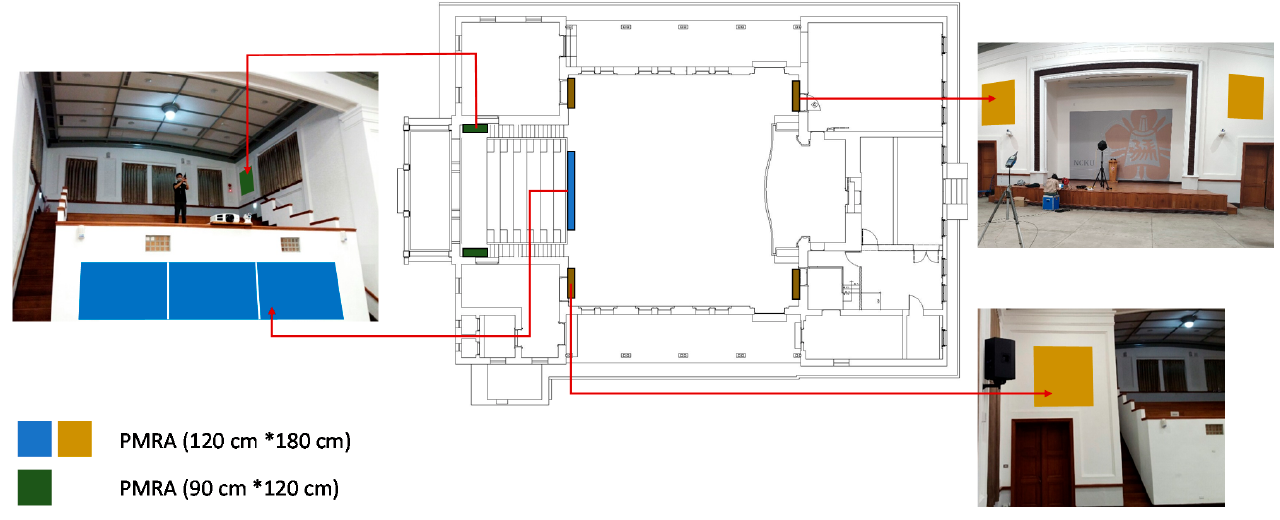
Figure 15. PMRA setting position.